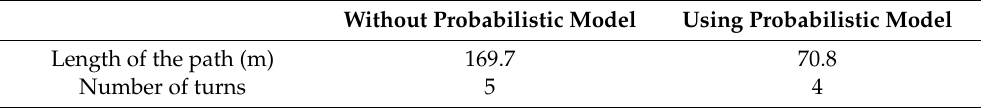
Figure 10. Path planning algorithms before and after model improvement. ( a ) Path planning based on episodic memory. ( b ) Path planning based on episodic memory with probability acceptance model introduced. Table 2. Comparisons of path planning algorithms.